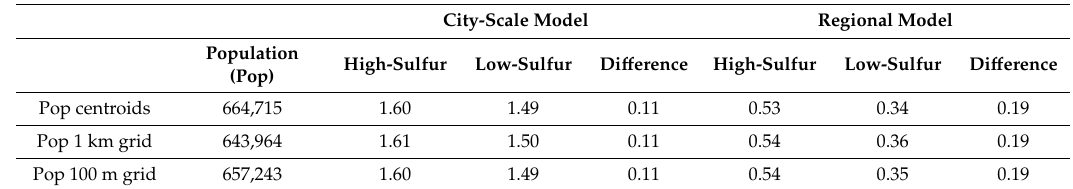
Table 2. Mean PM 2.5 population exposure ( µ g / m 3 ) from shipping emissions at city-scale and regional models using high- and low-sulfur scenarios for the Gothenburg area.